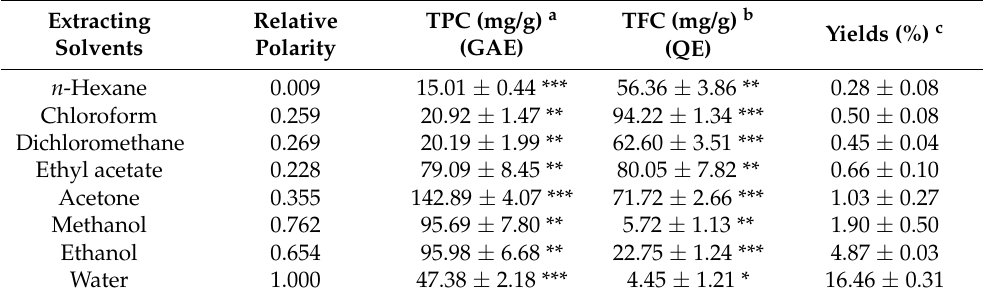
Table 1. Each extraction solvent from Ampelopsis japonica of TPC, TFC, and extraction yields.